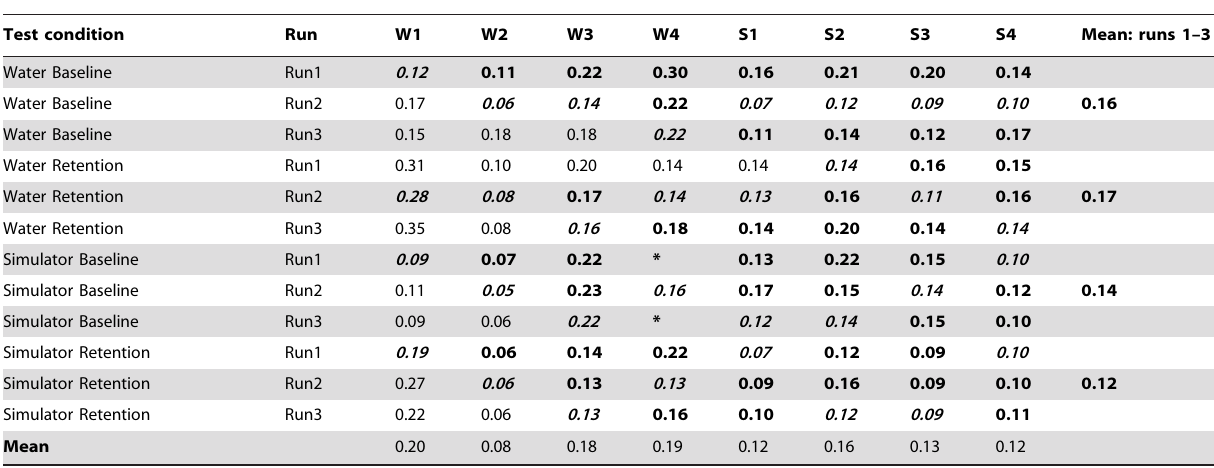
Table 1. Sums of coefficients of variation for all runs, tests, and participants.